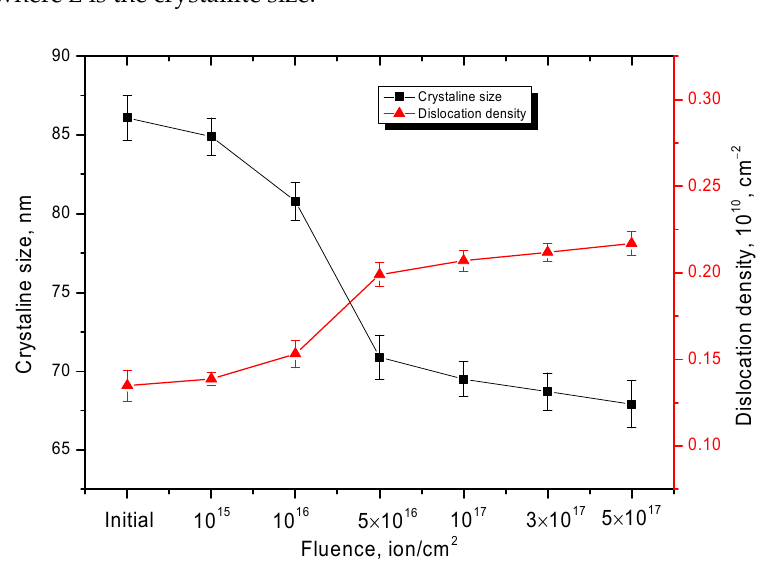
Figure 5. Results of change in crystallite sizes and dislocation density depending on irradiation fluence.